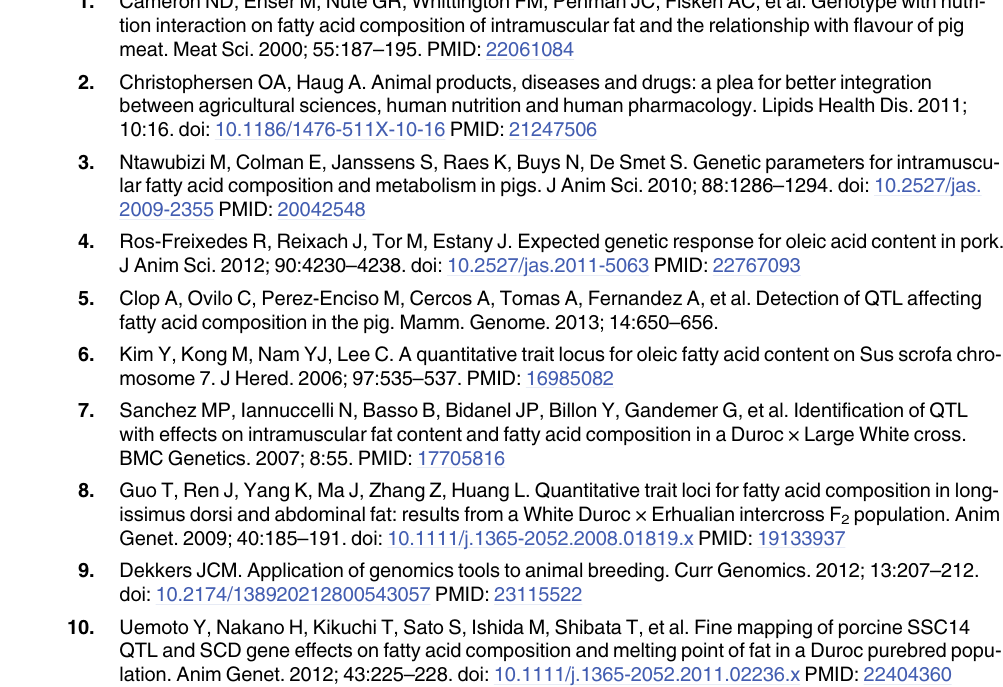
S2 Table. Minor allele frequency and number of animals per genotype within time period for the porcine SCD gene promoter (AY487830: g . 2228T > C ) and exon 14 of